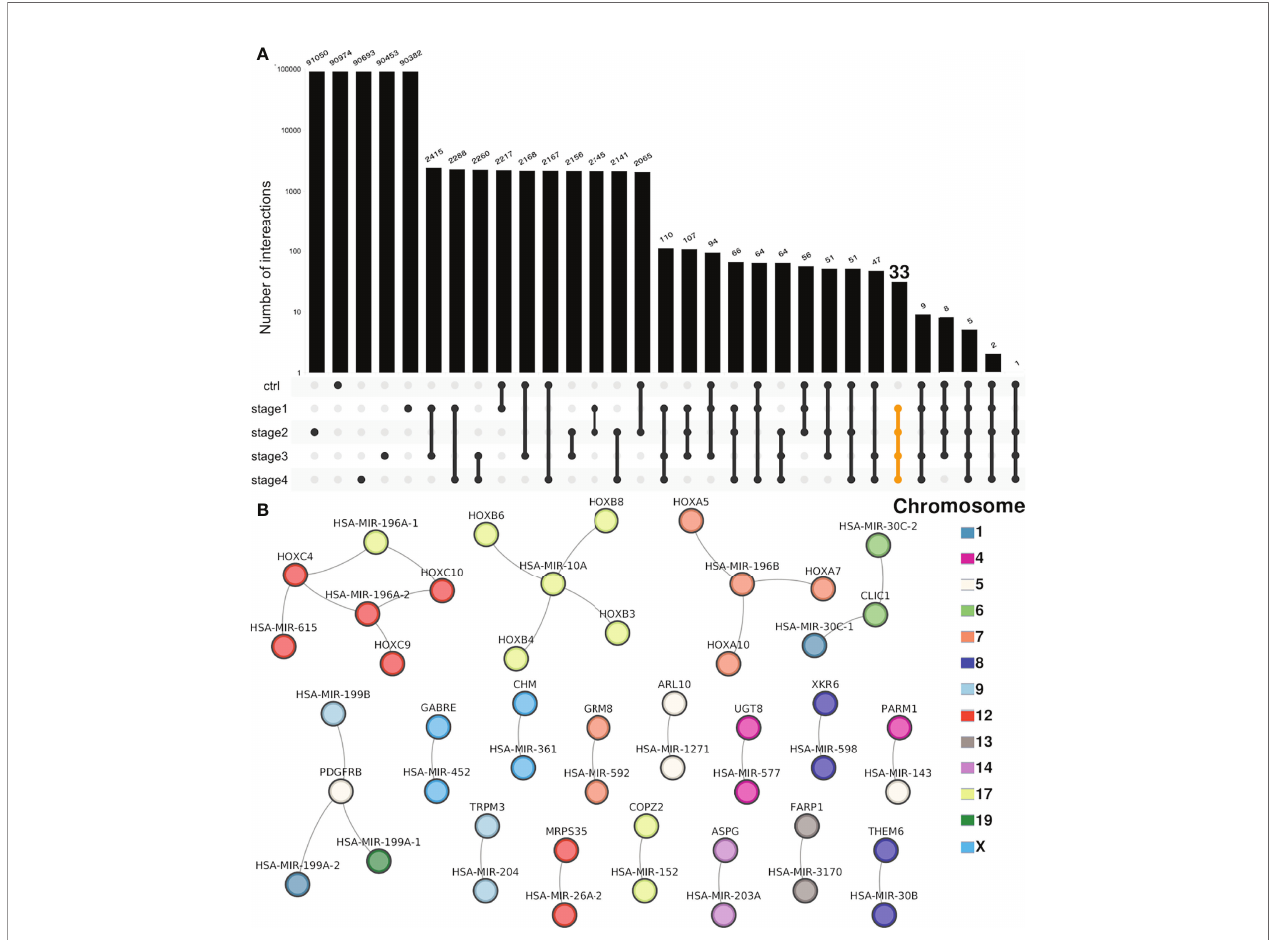
FIGURE 4 | Intersection of miR – gene co-expression networks. (A) Each bar in the UpSet plot represents the number of interactions in the selected set, represented by linked points below the bars (log scale). Above each bar, the number of interactions is shown. The fi rst fi ve bars account for unique interactions. From the sixth bar onward, each one of them shows the number of shared interactions between two or more networks. At the right side, the set of shared interactions between the four CCRC progression stages (but not NT) is highlighted in yellow. (B) The 33 shared interactions between the four progression stages but not shared with the non- tumor network are depicted. In the fi gure, the color of the nodes represents the chromosome where miRs and genes are